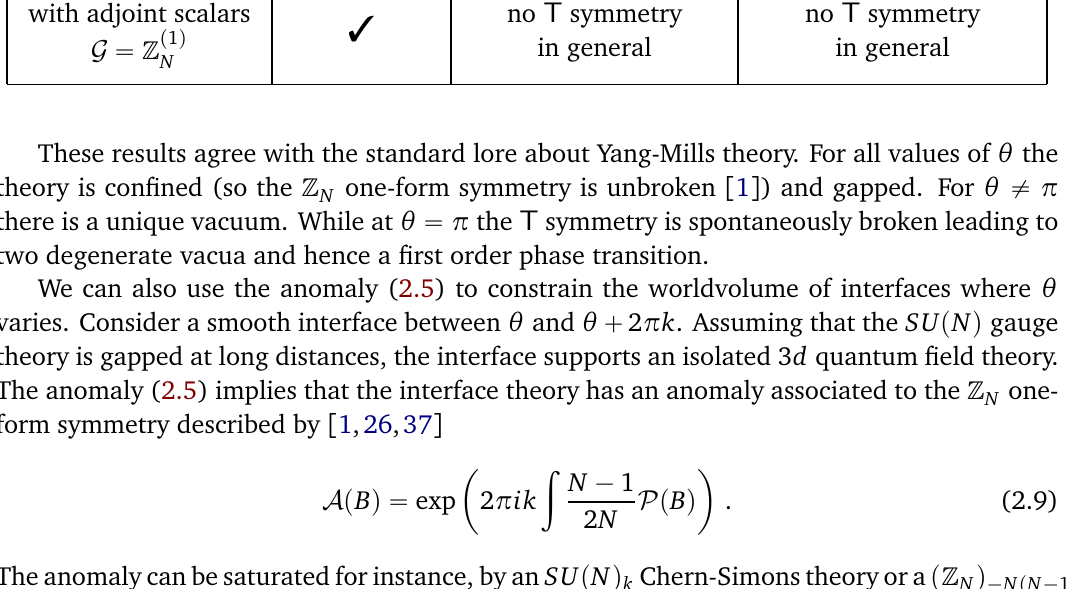
Table 2: Summary of anomalies and existence of continuous counterterms in various 4 d theories. The superscripts of the symmetries label the q ’s of q -form symmetries. theory without T with T at θ “ 0, π symmetry G θ - G anomaly T - G anomaly at θ “ π no smooth counterterms SU p N q gauge theory (cid:51) even N